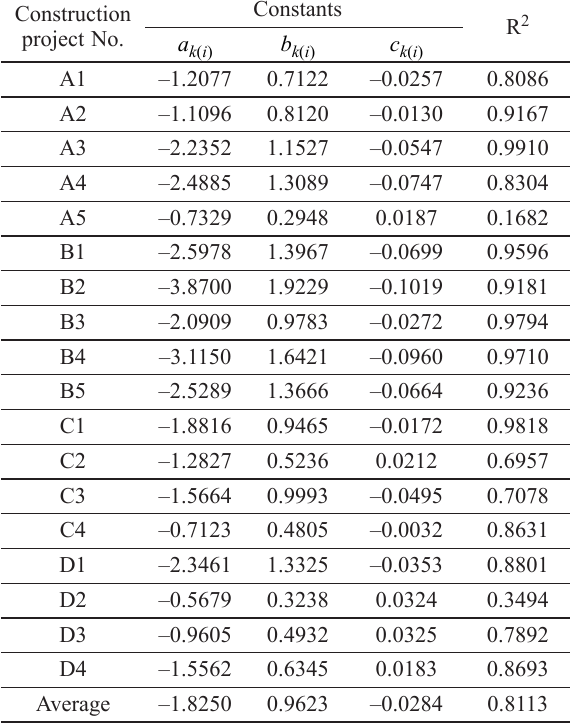
Table 6. Calculated values of R 2 of the regression lines for the five zones of all 18 projects Construction project No.